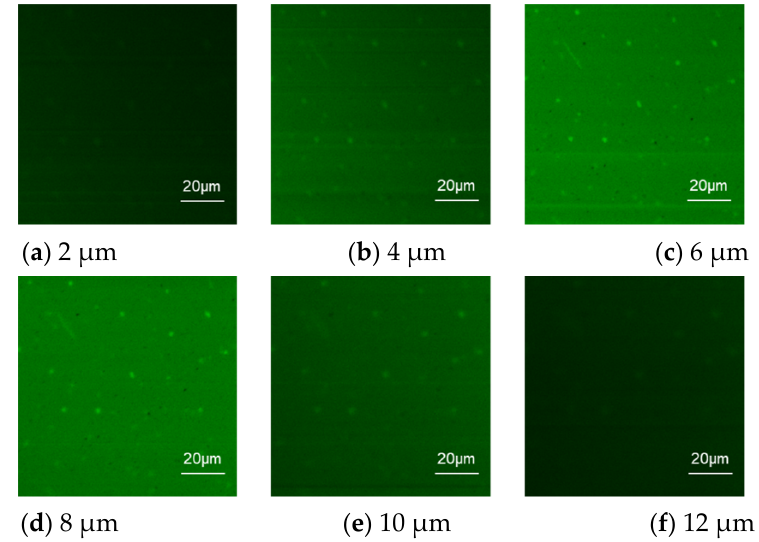
Figure 3. CLSM images at different depths.